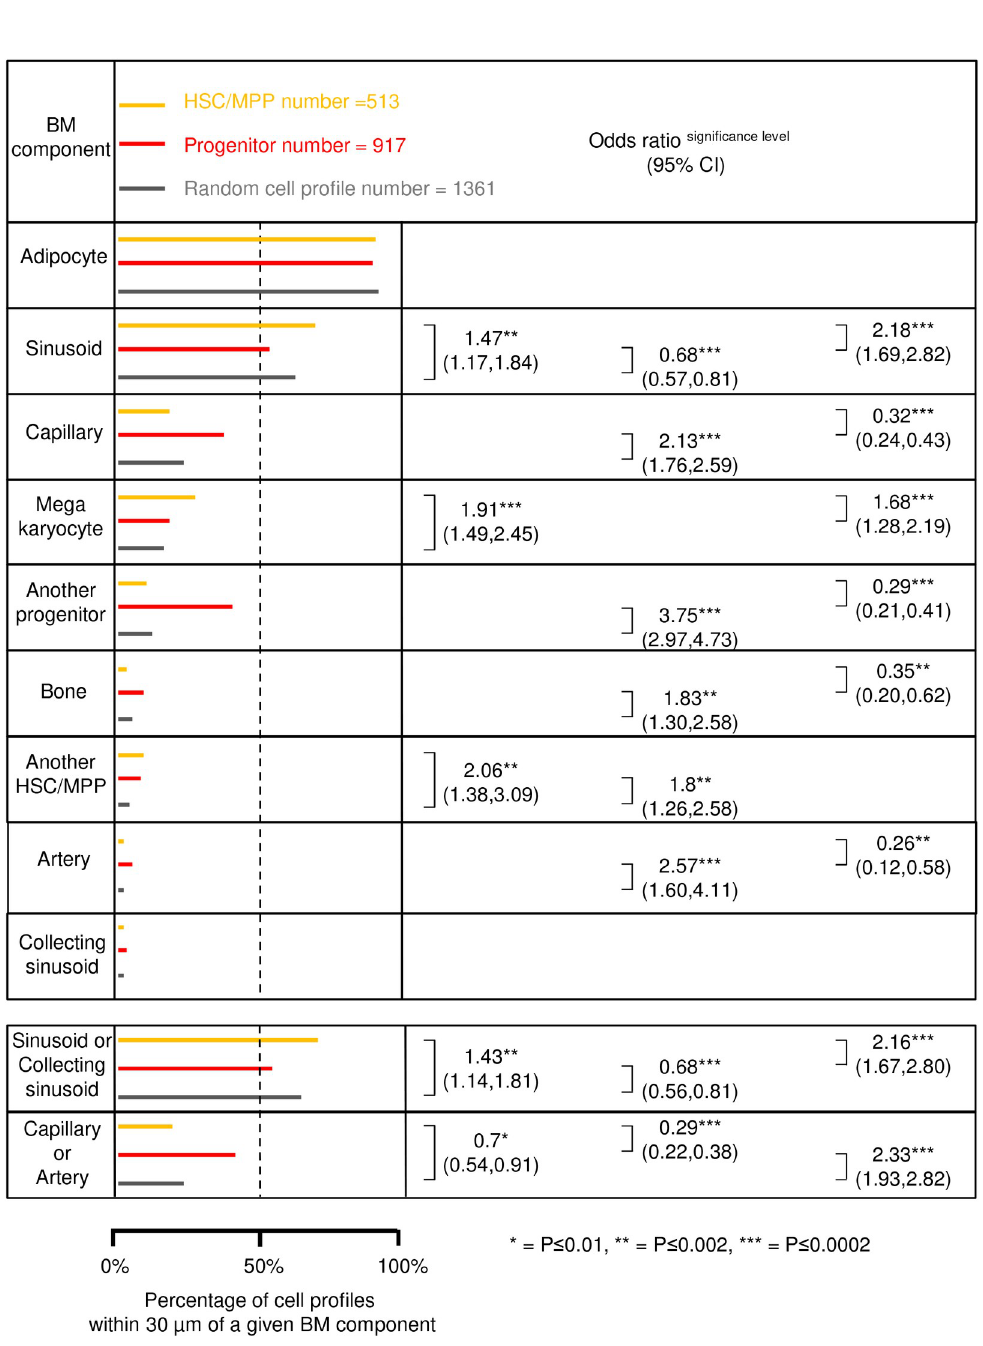
PLOS ONE | https://doi.org/10.1371/journal.pone.0250081 April 20, 2021 8 /